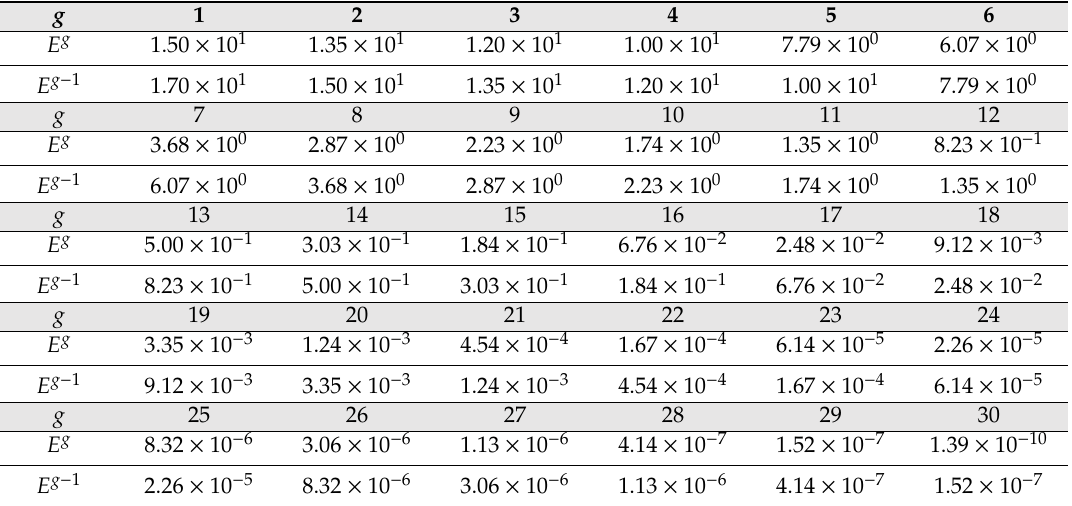
Table 2. Energy group structure, in [MeV], for PERP Benchmark